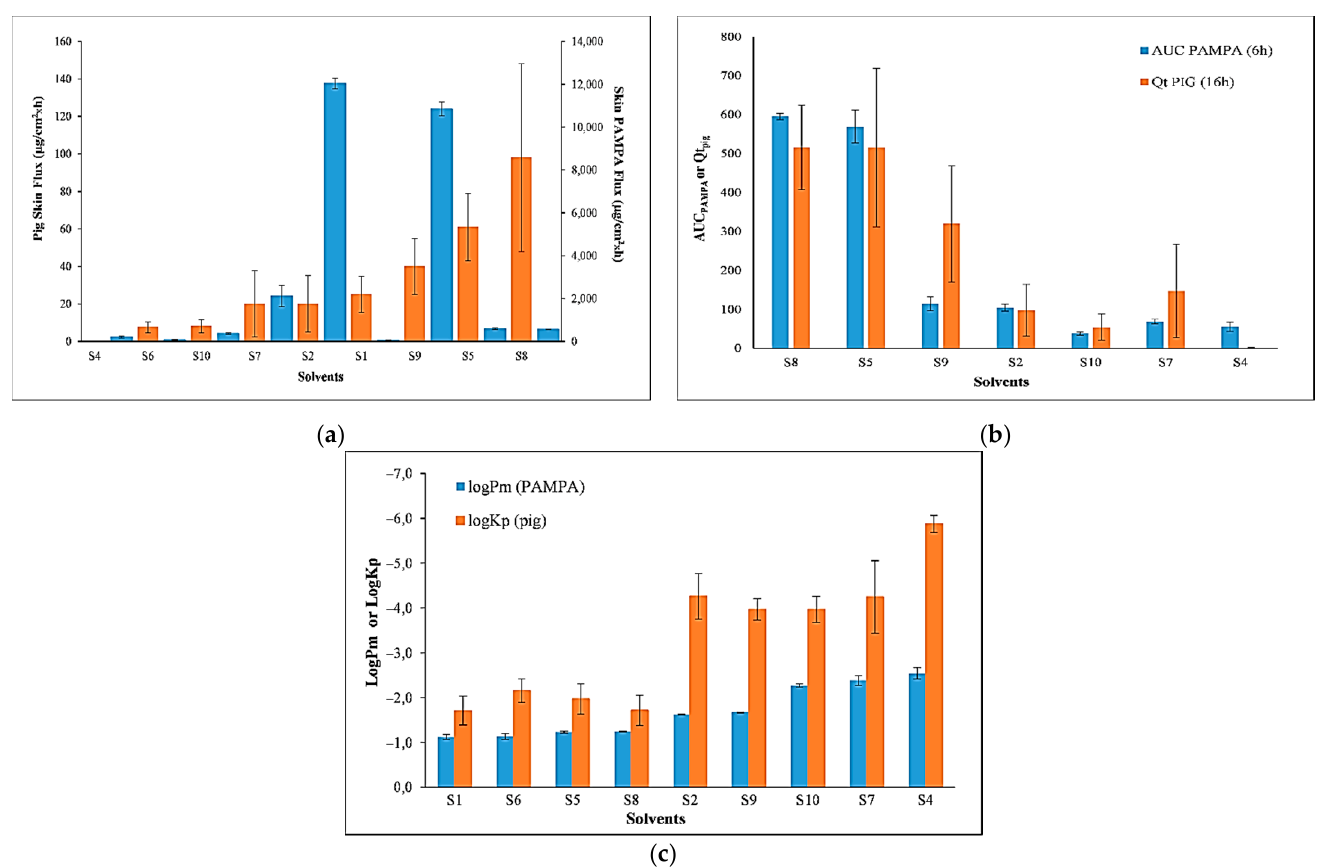
Figure 3. ( a ) Comparison of the permeability of PER in different solvents across Skin-PAMPA membranes (blue bars) and pig skin (orange bars), expressed as flux (no close correlation); ( b ) permeated amount ( R 2 = 0.834, n = 7); ( c ) permeability coefficient, logP m and logK p for Skin PAMPA and pig skin, respectively ( R 2 = 0.844, n = 9). All values are mean ± SD.